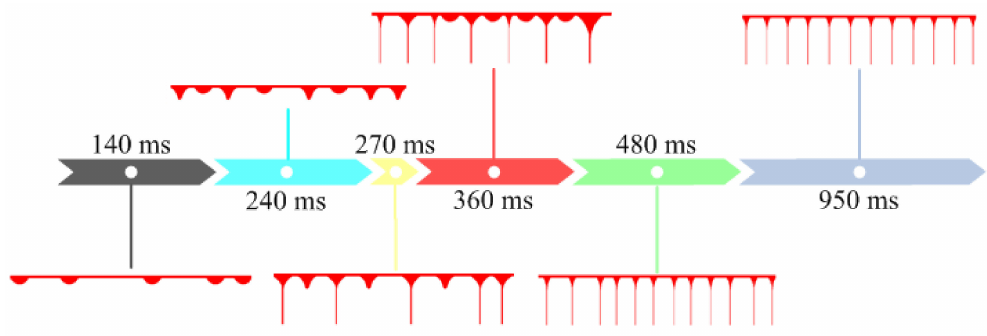
Figure 6. Schematic diagram of jets development process. (For ease of expression, the closed curve is straightened to a straight